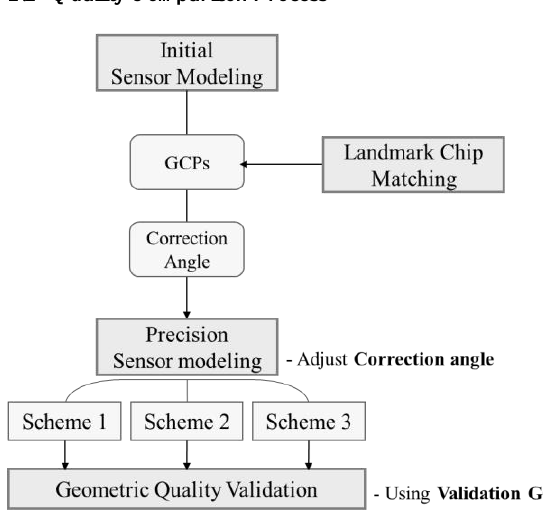
Figure 5. Quality comparison process